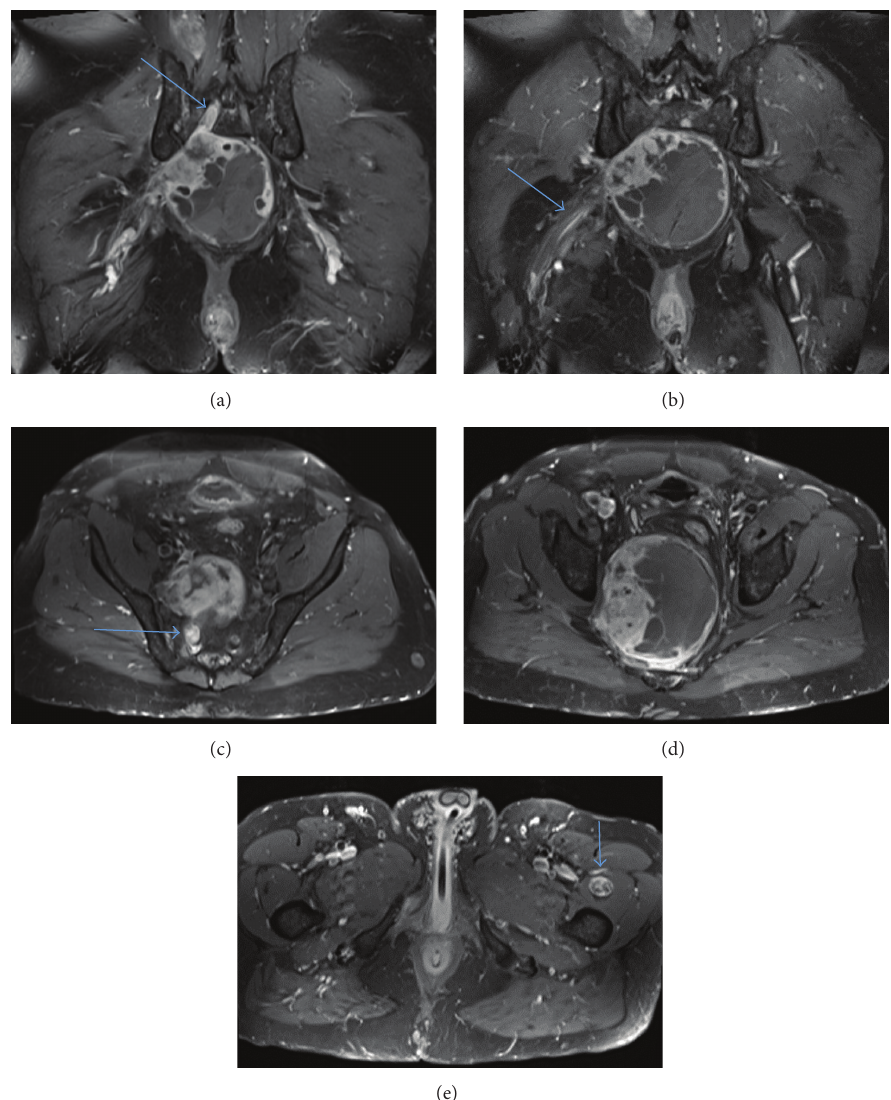
Figure 5: (a) Coronal T1 FS + contrast shows pelvic mass extending to the right S2 neuroforamen (arrow). (b) Coronal T1 FS + contrast shows pelvic mass (arrow points to right sciatic nerve). (c) Axial T1 FS + contrast shows pelvic mass extending to the right S2 neuroforamen (arrow). (d) Axial T1 FS + contrast shows pelvic mass. (e) Axial T1 FS + contrast shows left vastus medialis/intermedius muscle